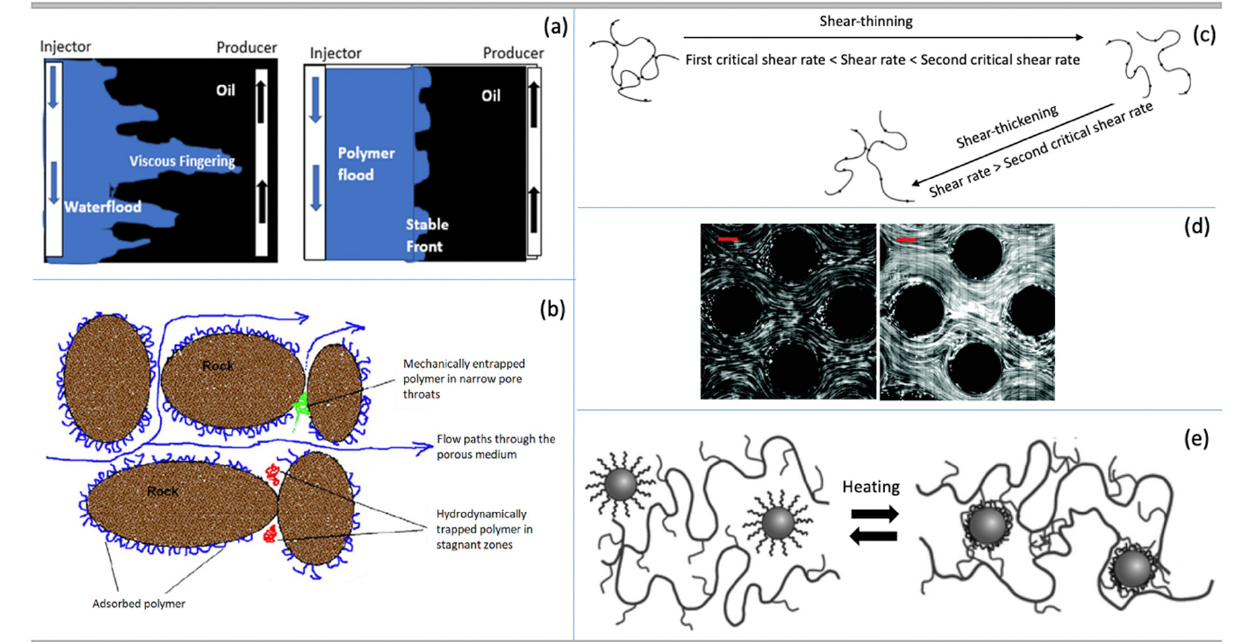
Figure 1. Oil recovery and transport mechanisms of water-soluble polymers, as will be discussed in this paper. ( a ) The decrease in water mobility due to the presence of polymer macromolecules in the water. Adapted with permission from [51]. ( b ) Polymer retention mechanisms in porous media. Adapted with permission from [52]. ( c ) Polymer rheology in porous media. Adapted with permis- sion from [53]. ( d ) Shear-thickening behavior of polymers caused by elastic instabilities. Adapted with permission from [54]. ( e ) Improved rheological properties in harsh conditions by dispersions composed of a hybrid of nanoparticles and water-soluble thermo-responsive polymers. Adapted with permission from [55].